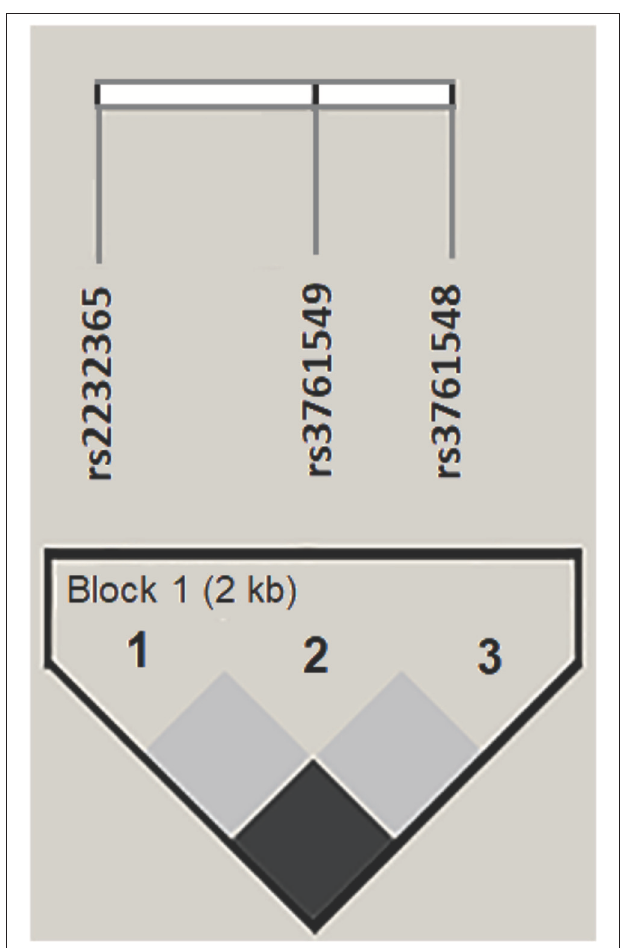
FIGURE 2 | Linkage disequilibrium (LD) for polymorphisms in the FOXP3 gene promoter region generated in Haploview 4.2. The horizontal white bar illustrates the physical arrangement of polymorphisms along the gene. The normalized linkage disequilibrium coefficients (D’) were equal to 1 for all combinatorial analyses. A 2-kb haplotype block was inferred in the